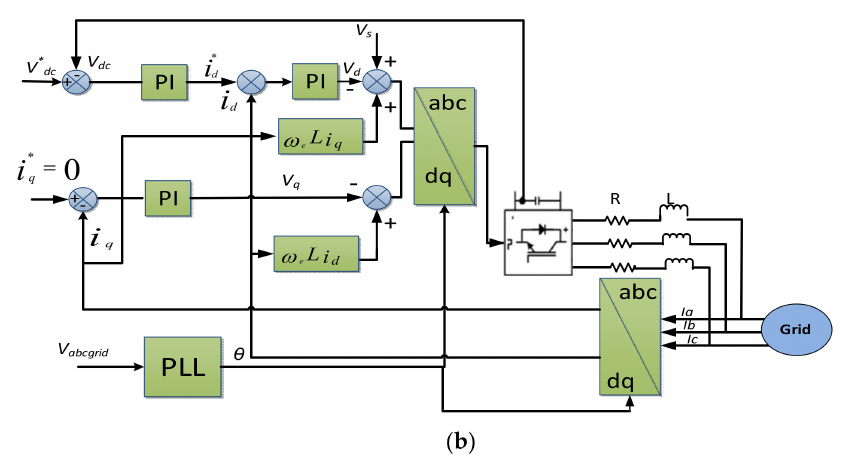
Figure 5. Grid side converter: ( a ) topology, and ( b ) controller block